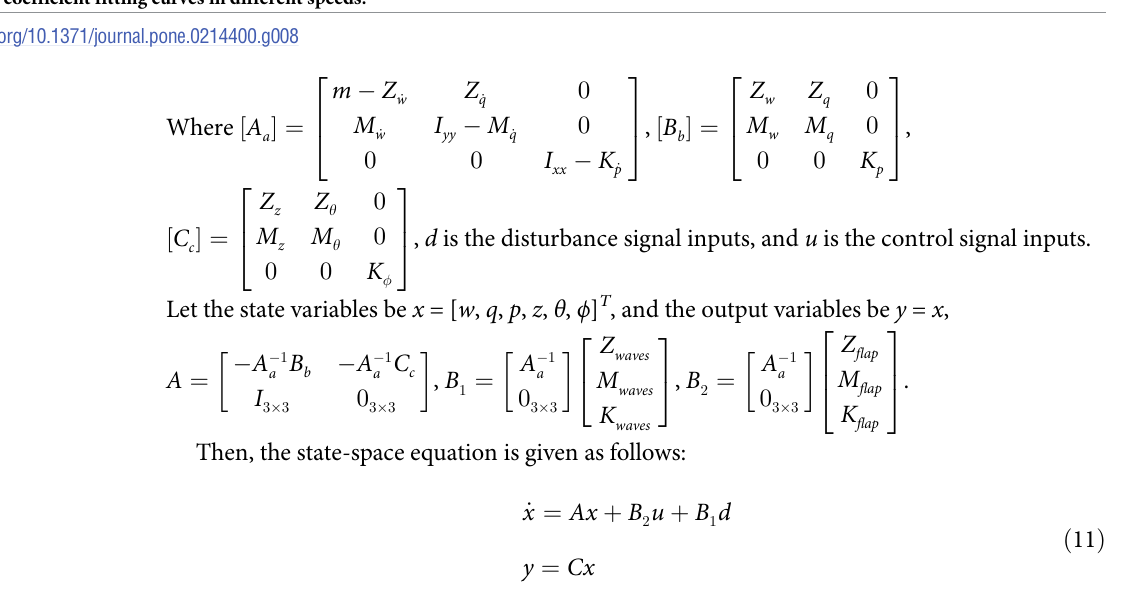
Fig 8. Lift coefficient fitting curves in different